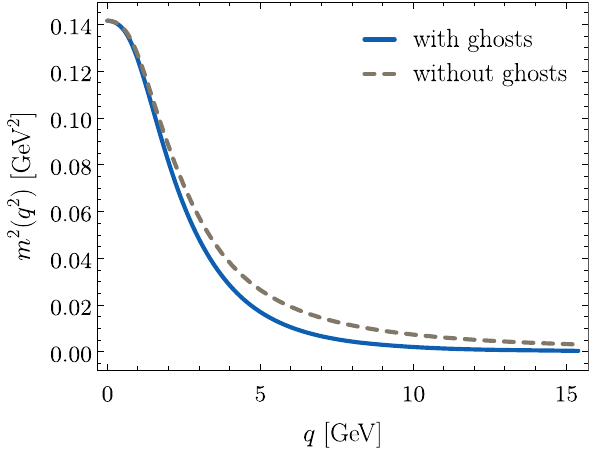
Fig. 8 The gluon mass scale obtained by integrating the gluon BSE solution, compared to the one obtained in the absence of ghosts